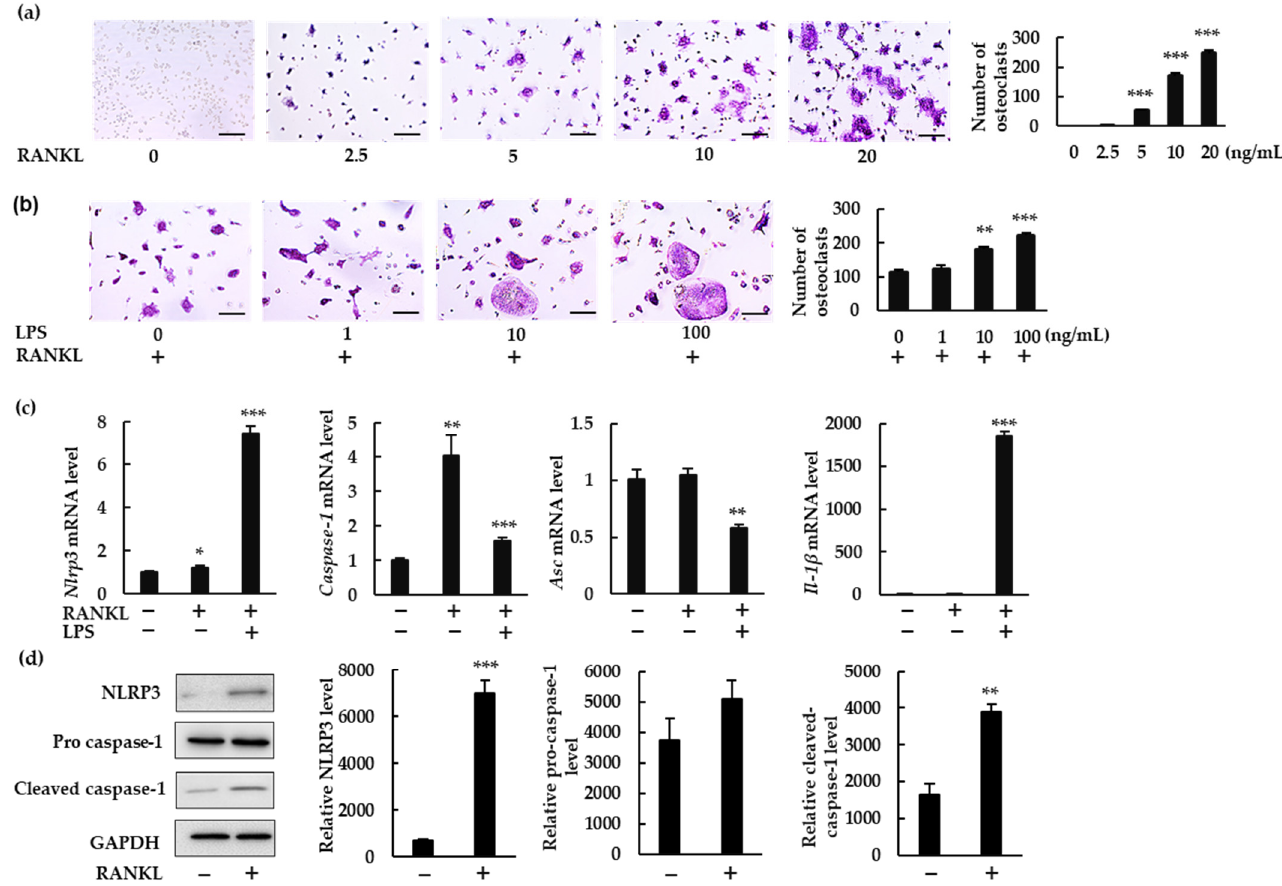
Figure 1. NLRP3 inflammasome-related gene and protein expression in bone marrow macrophages (BMMs) treated with receptor activator of nuclear factor- κ B ligand (RANKL) in the presence or absence of lipopolysaccharide (LPS). ( a ) BMMs were treated with macrophage-colony-stimulating factor (M-CSF; 30 ng/mL) and RANKL (0, 2.5, 5, 10, or 20 ng/mL) for 72 h. ( b ) BMMs were treated with RANKL (5 ng/mL) and M-CSF (30 ng/mL) for 48 h, then stimulated with LPS (0, 1, 10, or 100 ng/mL) for an additional 48 h in the presence of the same concentrations of M-CSF and RANKL. ( a , b ) Cells were then subjected to tartrate-resistant acid phosphatase (TRAP) staining. TRAP-positive cells with three or more nuclei were counted as osteoclasts. ( c ) BMMs were treated with RANKL (0 or 20 ng/mL) and M-CSF (30 ng/mL) in the presence or absence of LPS (10 ng/mL) for 7 h. Total RNA was extracted from cells and the relative expression of Nlrp3 , Caspase-1 , Asc , and Il-1 β mRNA